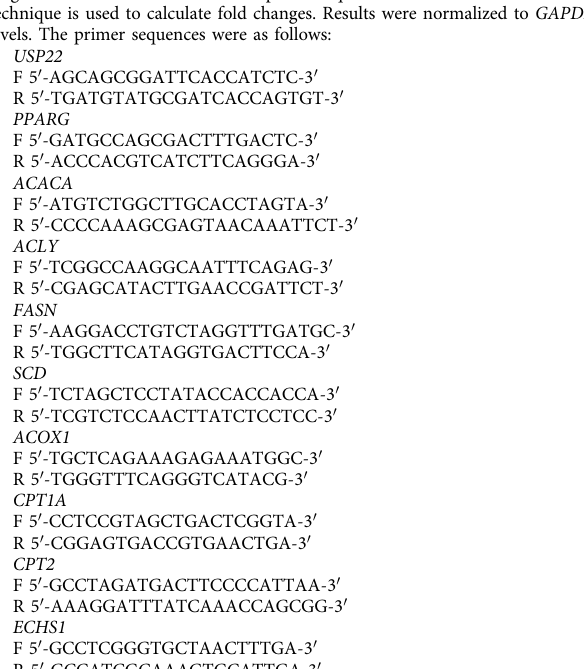
are provided in the Source Data